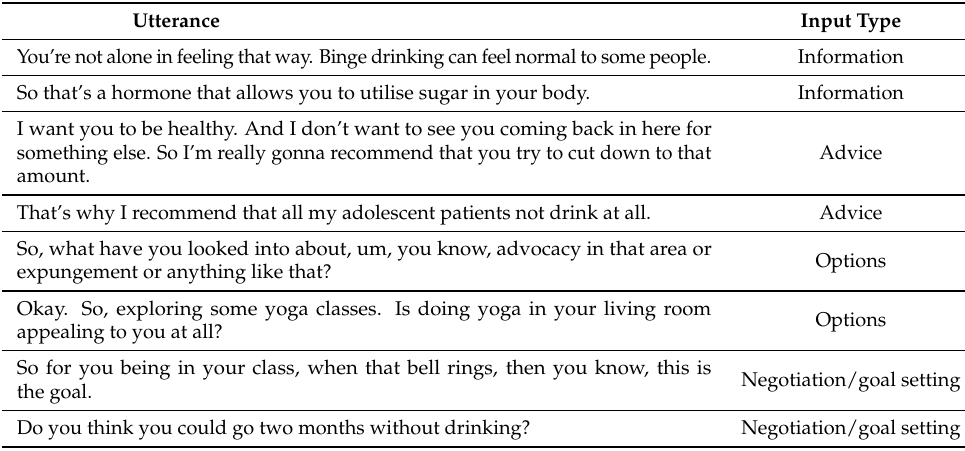
Table 6. Example labelling for therapist Input from the dataset.